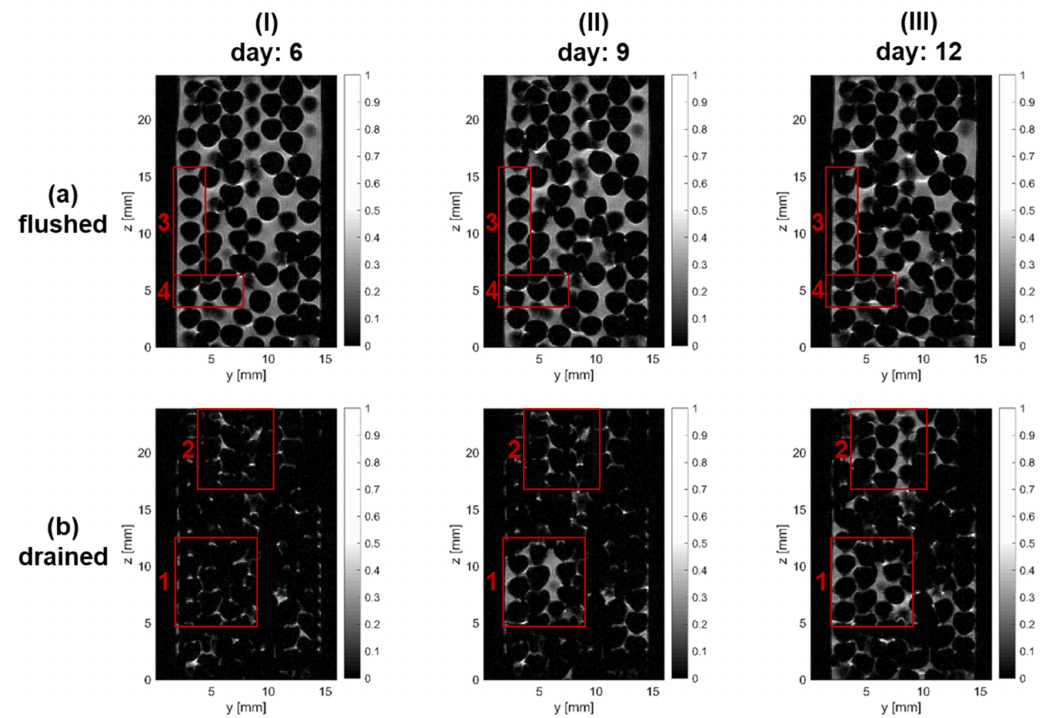
Figure 2. Two-dimensional MRI images displaying the normalized signal intensity in the flushed ( a ) and drained ( b ) conditions on days 6, 9, and 12. ( a ) Biofilm growth can be recognized in the form of dark regions appearing next to contact points of glass spheres. For further clarification, view the highlighted animation (see Supplementary Materials). ( b ) Water retention increases within the porous medium due to the growth of biofilm. Regions of interest (ROIs) that reveal occurring changes are highlighted in